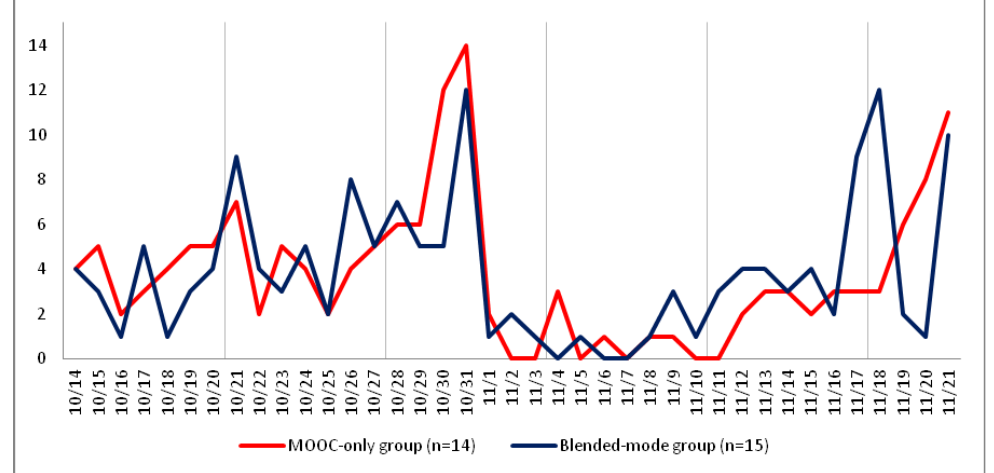
Figure 2. General trend in students’ activity in the integrated BE101X and in the two weeks in between based on the number unique daily online